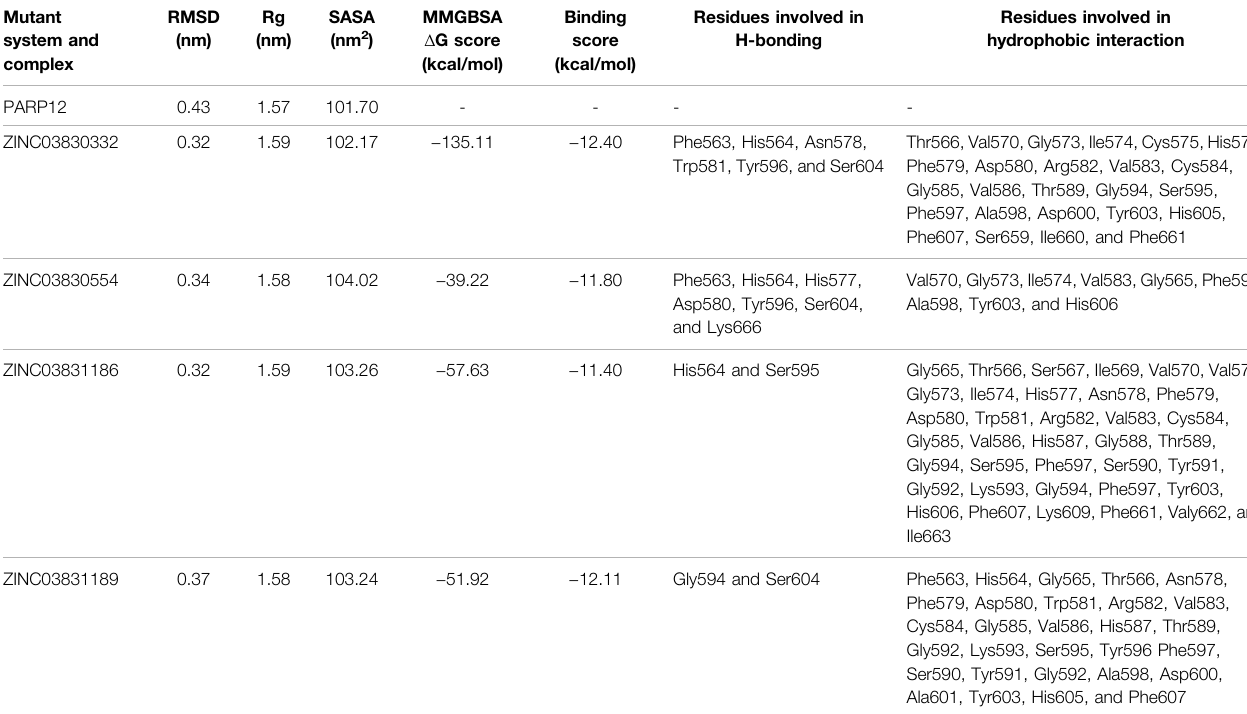
Residues involved in